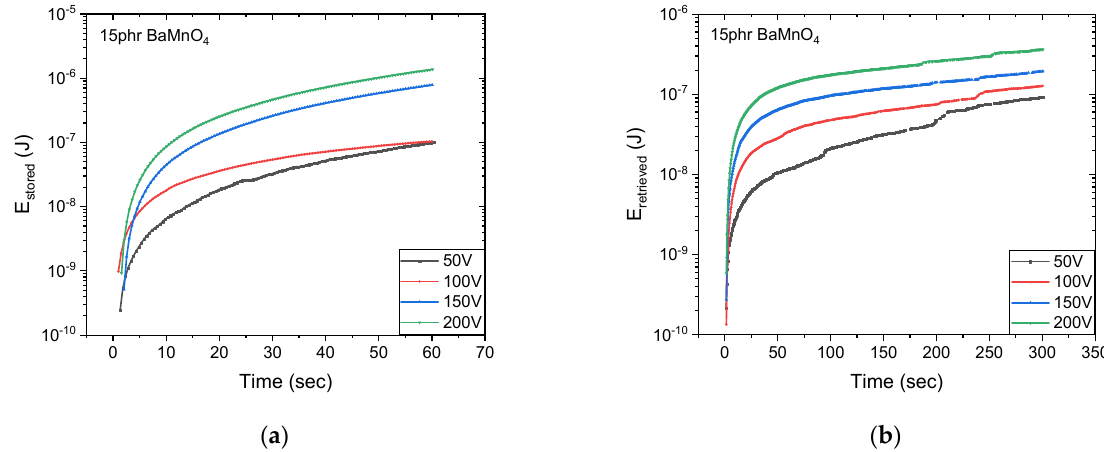
Figure 4. ( a ) Stored (charging procedure) and ( b ) retrieved (discharging procedure) energies (E stored , E retrieved ) as a function of time for the 15 phr BaMnO 4 nanocomposite at different DC voltage levels.